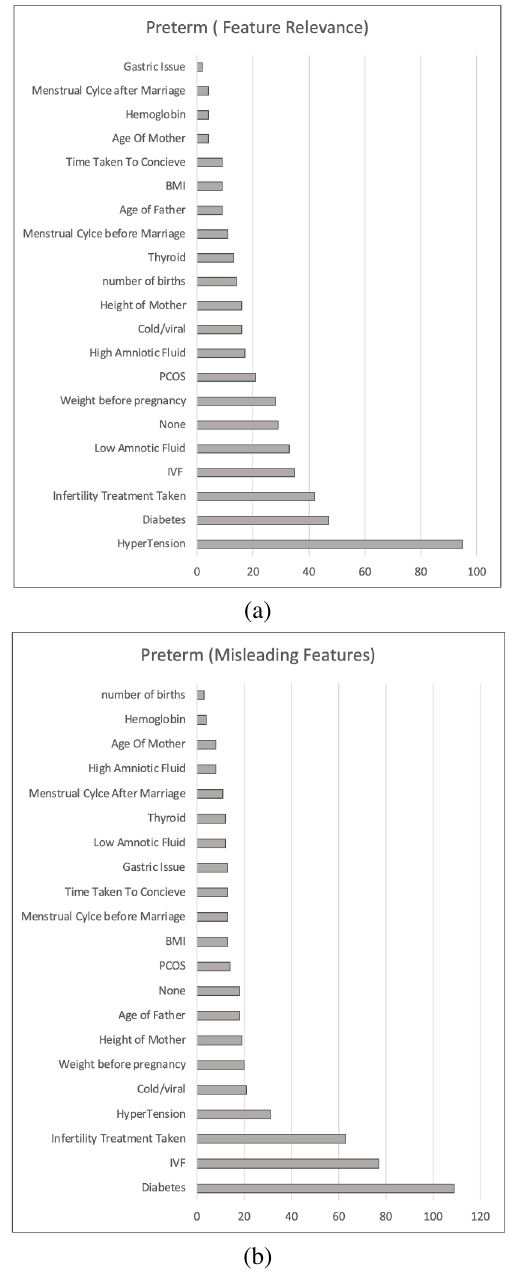
Fig. 1: Physical feature for Preterm birth